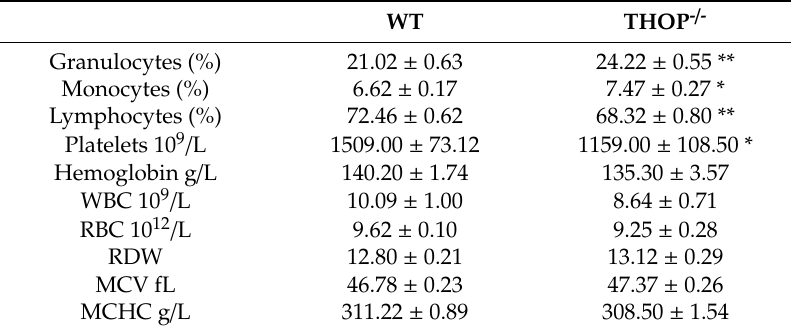
Table 2. Complete blood count for wild type (WT) and THOP1 - / - animals.